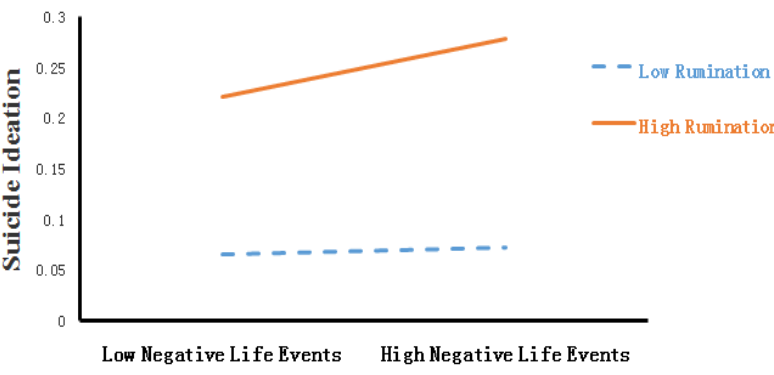
Figure 3. A simple slope test for the analysis of the moderating effect of rumination.